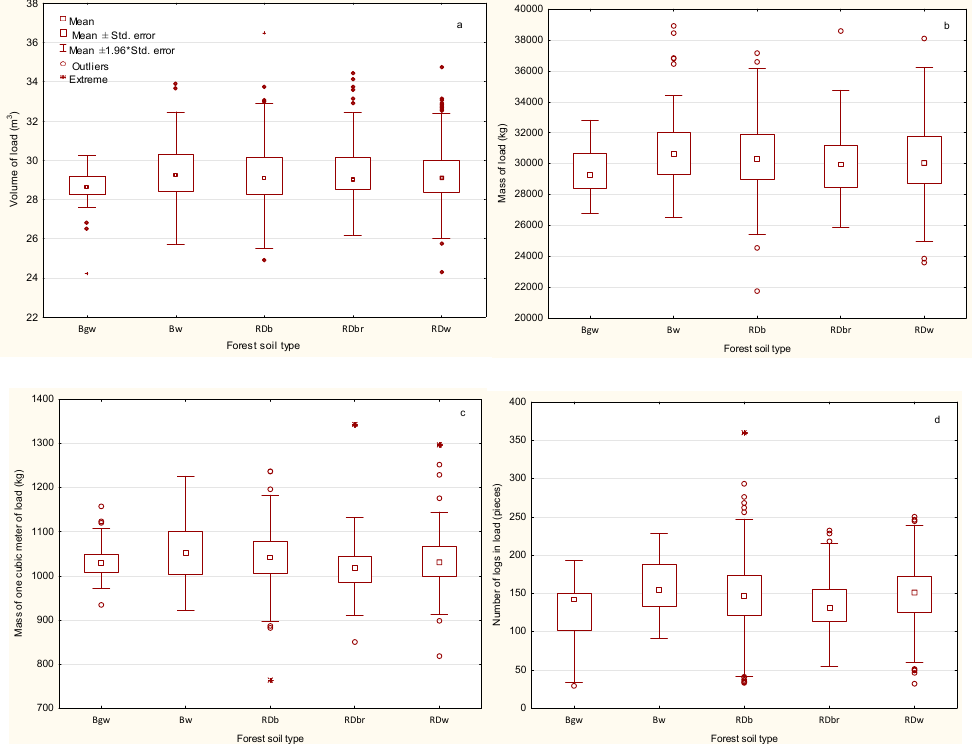
Figure 5. Comparison of average values characterizing timber loads depending on the type of soil in which the harvested trees grew. ( a ) load volume, ( b ) load mass, ( c ) mass of 1 m 3 , ( d ) number of logs (pieces). Bgw—(proper) gley podzolic soil, Bw—podzolic soil, RDb—podzolic rusty soil, RDbr—brown rusty soil, RDw—(proper) podzolic soil.